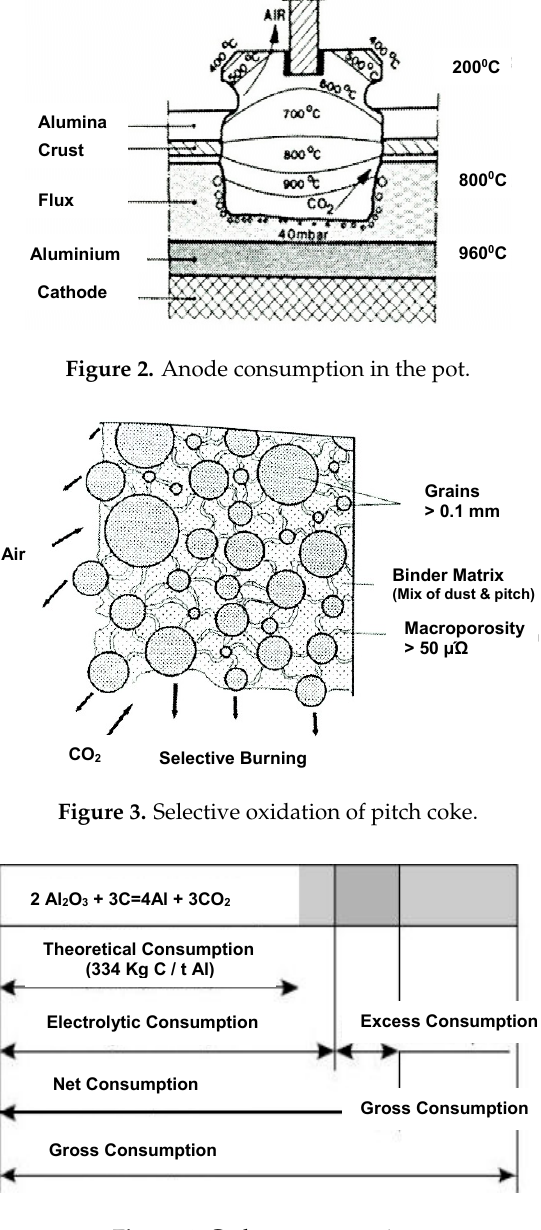
Figure 4. Carbon consumption.